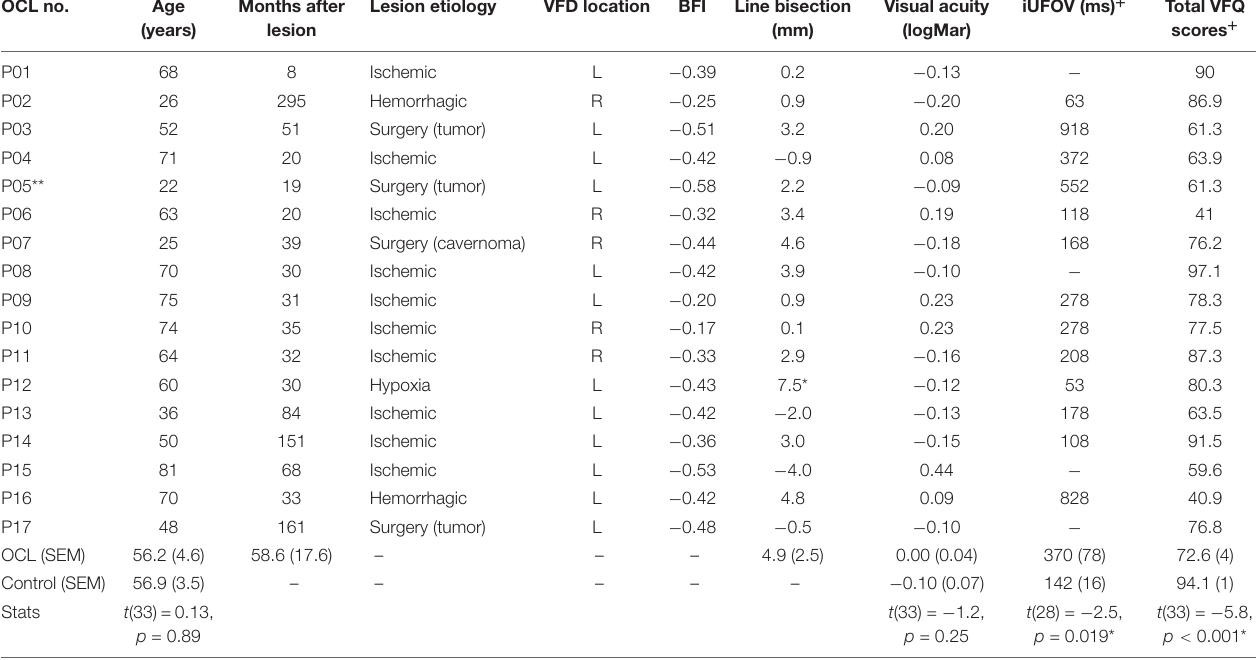
TABLE 1 | Demographic and clinical details of the OCL participants and the averages of the healthy controls. OCL